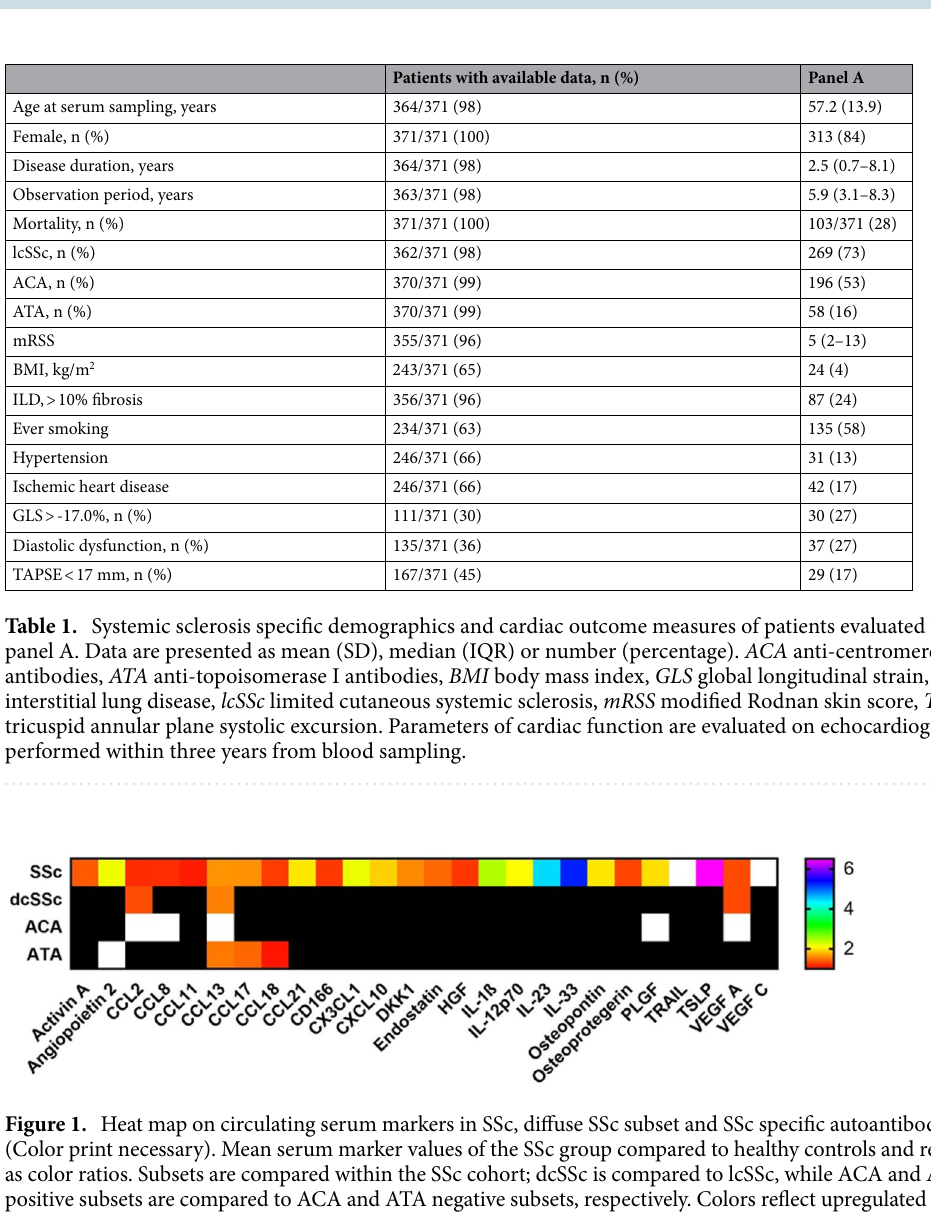
Patients evaluated for cardiac dysfunction in the study cohort. Echocardiographic data on GLS, LV diastolic dysfunction and/or TAPSE, within three years from serum sampling, was available in 188/371 (51%) study cohort patients (Fig. 2). Patients with available echocardiography within 3 years from serum sampling